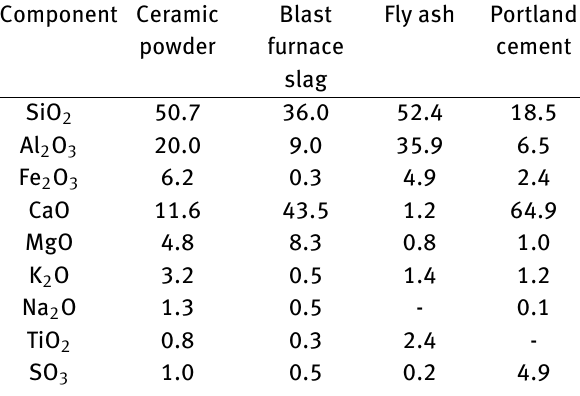
Table 2: Chemical composition of used binding components [%].